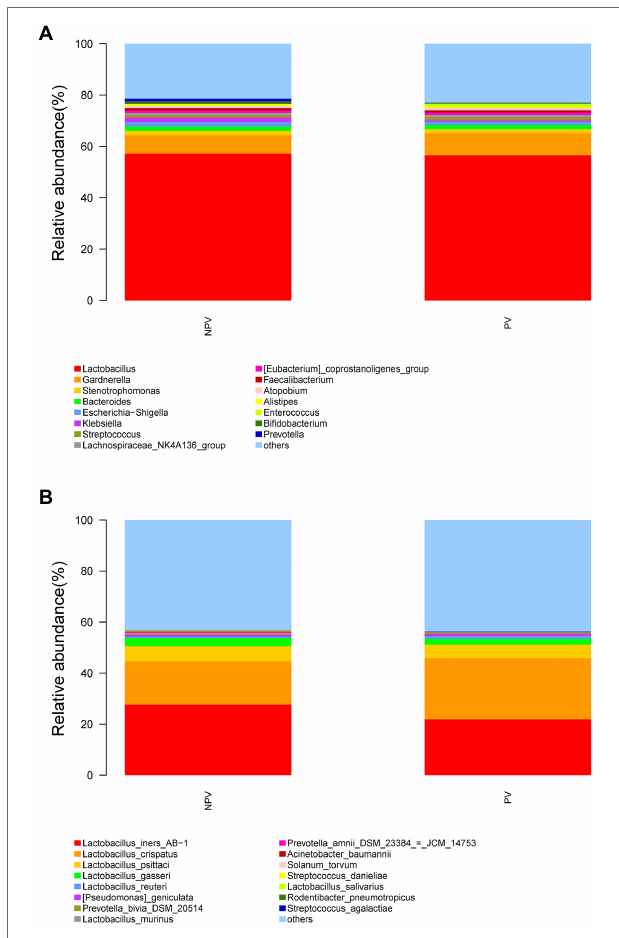
FIGURE 5 | Vaginal microbial composition of pregnant and non-pregnant groups. The relative abundance of the top 15 genera in the vagina at the genus level (A) and species level (B) in pregnant and non-pregnant groups.